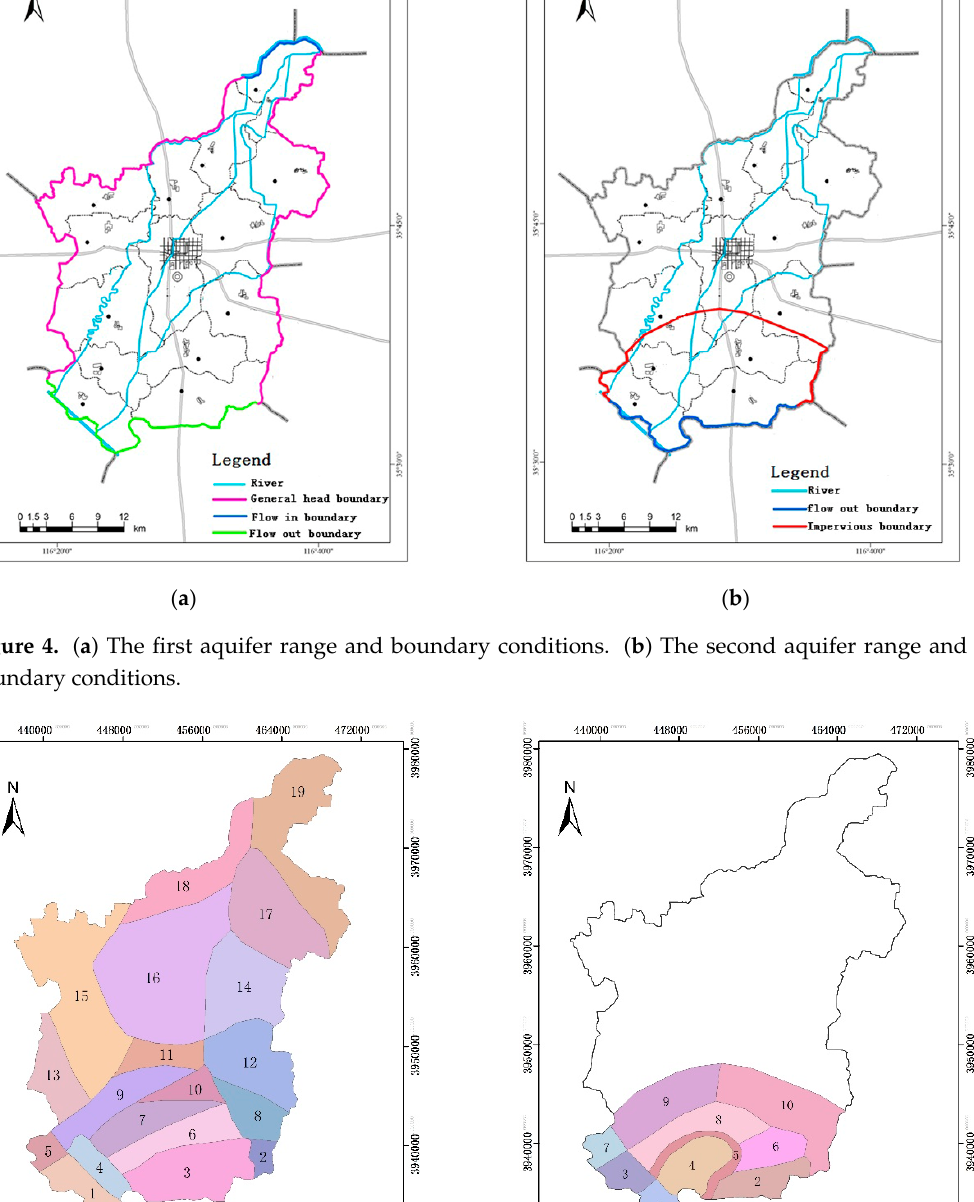
Figure 5. ( a ) Hydrogeological parameter partitions in the first aquifer; ( b ) hydrogeological parameter partitions in the second aquifer.